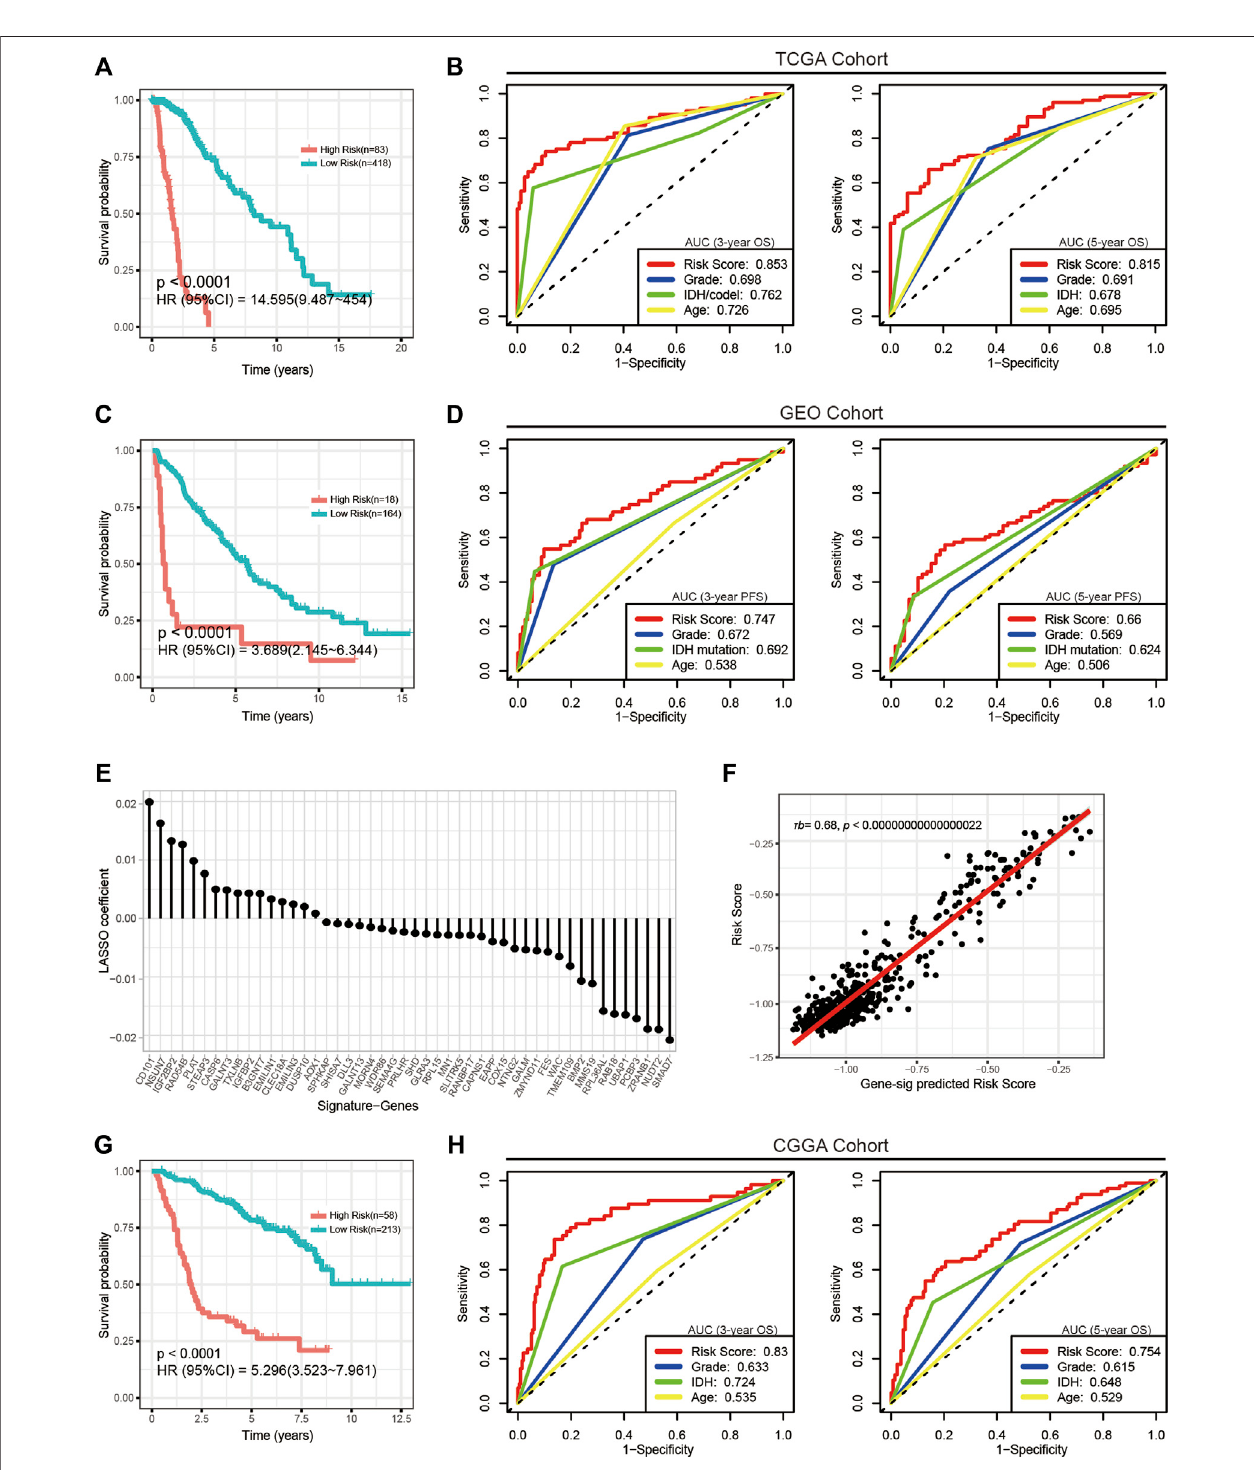
FIGURE 4 | Evaluation of the CpG signature in the TCGA, GEO and CGGA cohorts. (A,G) Kaplan-Meier analysis stratifying overall survival in the TCGA (A) and CGGA (G) cohorts. (C) Kaplan-Meier analysis stratifying progression-free survival in the GEO cohort. (B,H) ROC curves and AUC values showing the performance in predicting3-year(left)and5-year(right)survivalintheTCGAandCGGAcohorts. (D) ROCcurvesandAUCvaluesshowingtheperformanceinpredicting3-year(left)and 5-year (right) progression. (E) Signature genes and corresponding coef fi cients in the alternative gene signature. (F) Plot of the correlation between the alternative gene signature predicted risk scores and actual risk scores calculated by the CpG signature. τ b, Kendall ’ s tau-b.